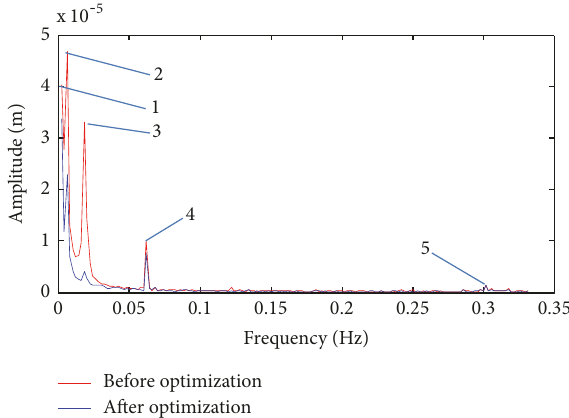
Figure 17: Frequency-domain comparison of LTE prior to and following